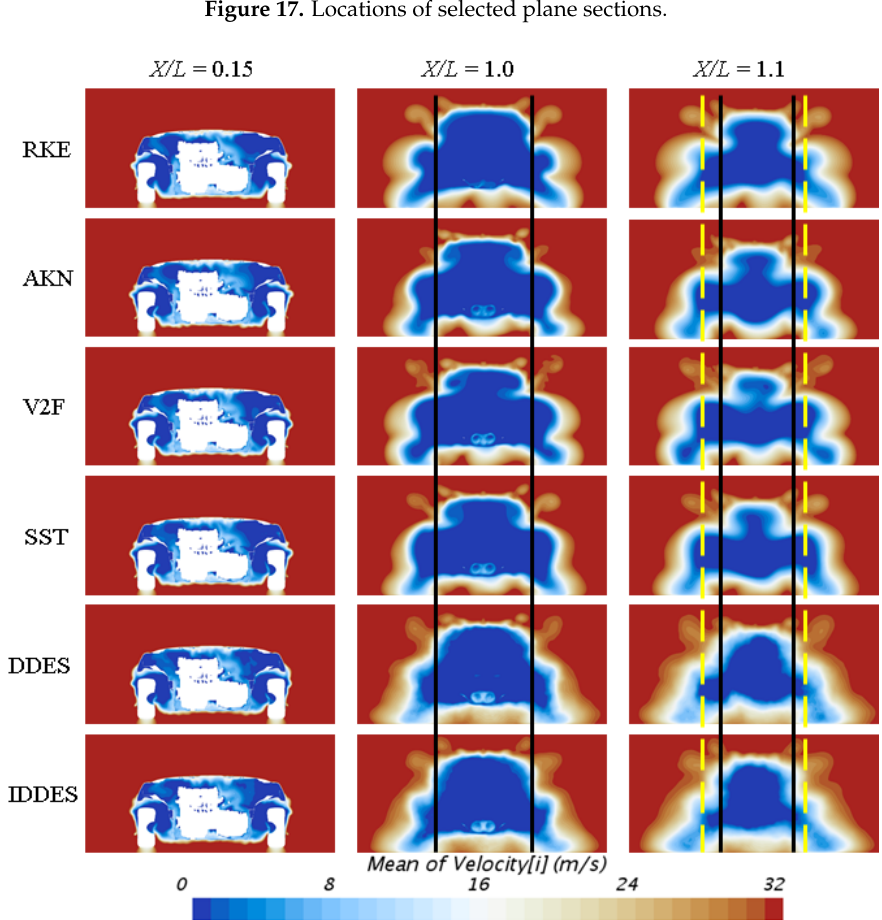
Figure 18. Streamwise velocity on selected plane sections from all models for the baseline